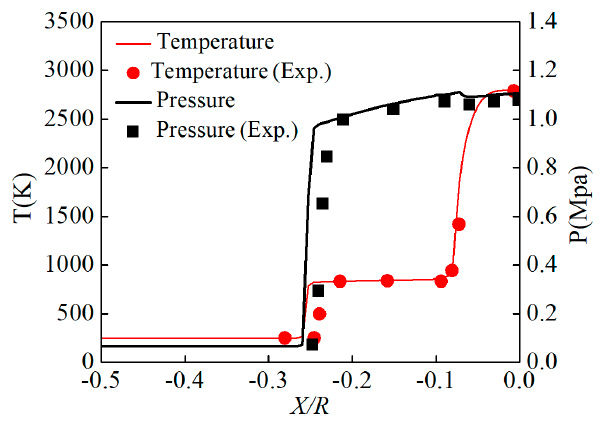
Figure 10. The temperatures and pressures of simulation and experiment.